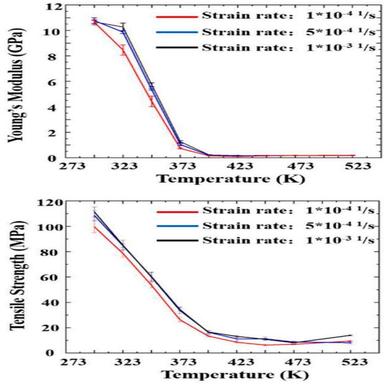
Relationship between Young's modulus and tensile strength of the